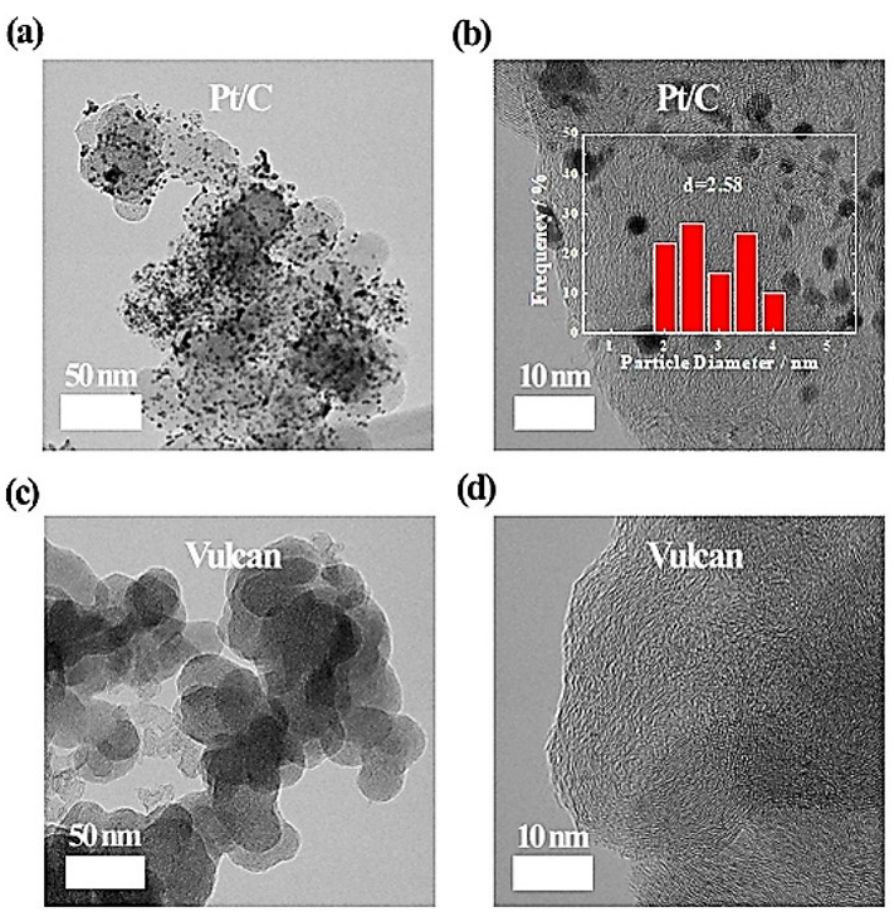
Figure 1. TEM images of ( a , b ) Pt/C and ( c , d ) Vulcan XC − 72. The inset of ( b ) shows the size distribution of Pt nanoparticles of